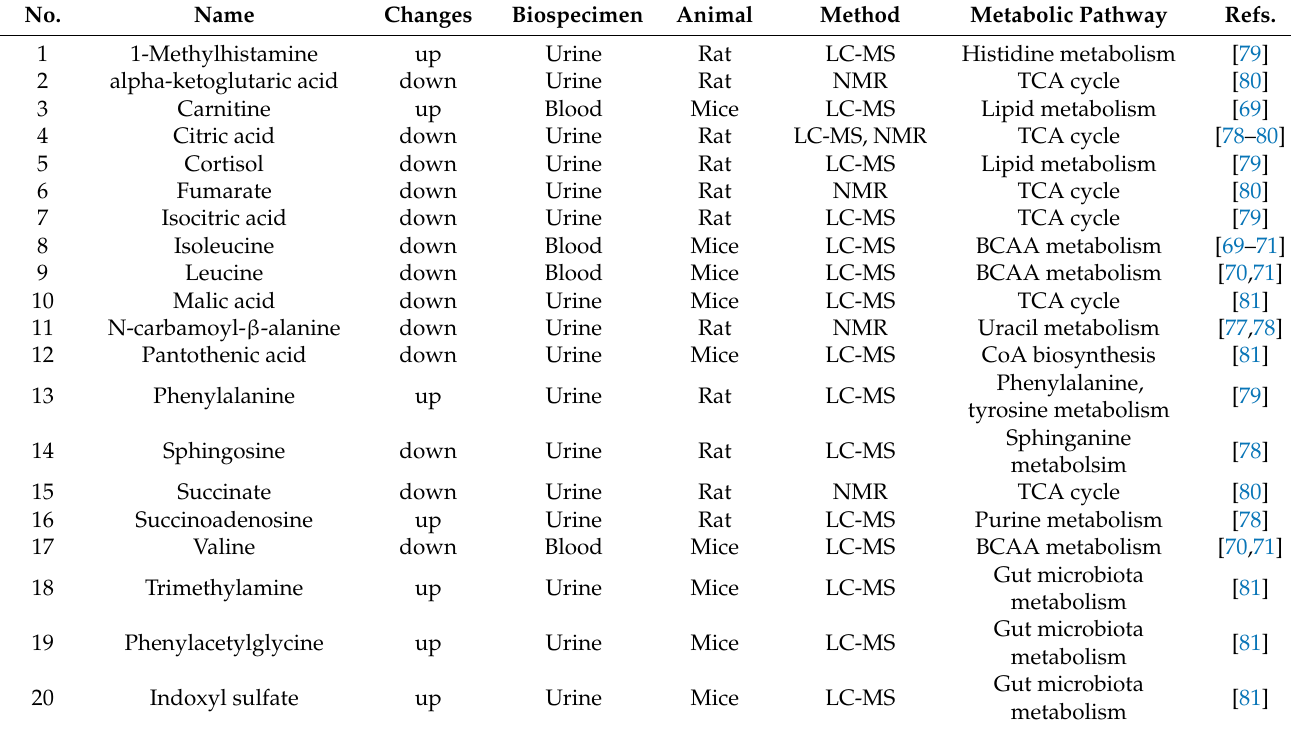
Table 3. Summary of metabolite changes following metformin administration in insulin-resistant in vivo models. ( p ≤ 0.05).